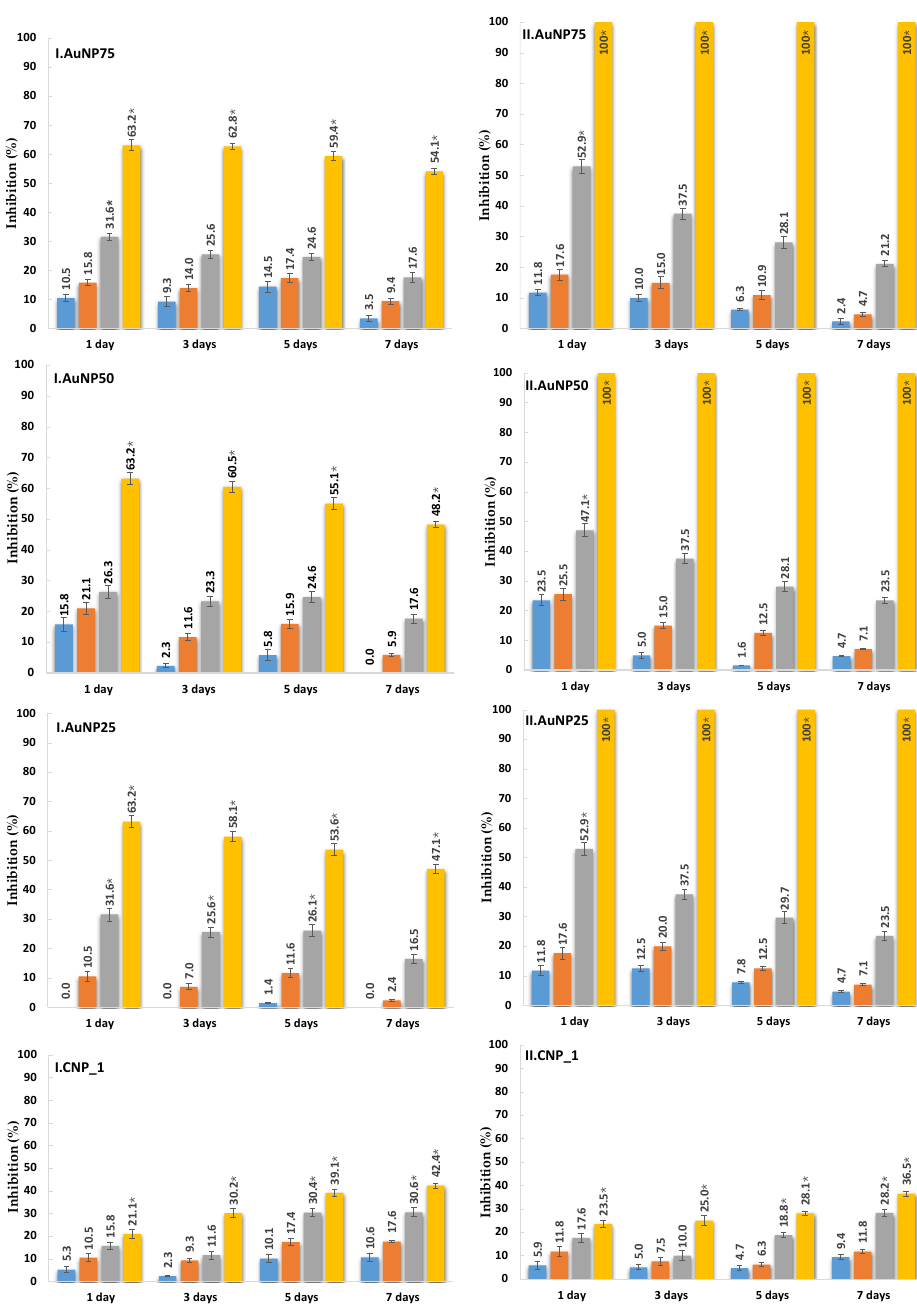
Figure 6. Antifungal activity of gold–chitosan (AuNPs–chitosan) and carbon nanoparticles (CNPs) applied at di ff erent concentrations and dosage on two Fusarium oxysporum strains grown on PDA medium after 1, 3, 5, and 7 days of incubation at 28 ◦ C. Fusarium oxysporum strains DSM 62338 (I) and DSM 62060 (II) with di ff erent concentrations, ranging from 25 to 75 µ g / mL in the case of AuNPs–chitosan and 19 mg / mL in case of CNPs. The percentages of growth inhibition were calculated in relation to the control. Error bars represent a standard deviation from the mean ( n = 3). Significant di ff erences ( p < 0.05) are marked with an asterisk.